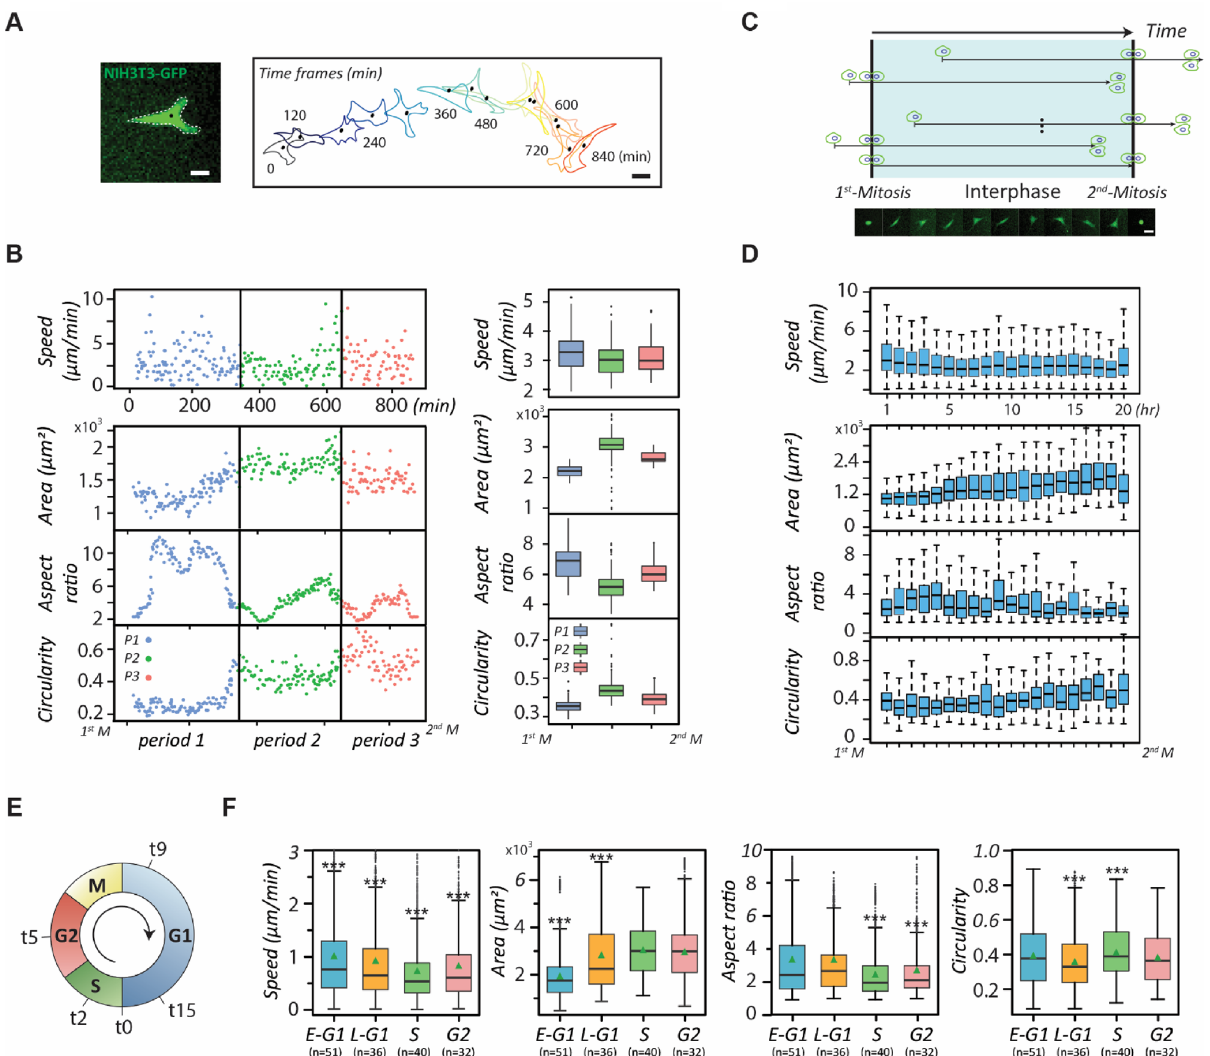
Figure 1. The evolution of migration and morphology of NIH fibroblasts over the cell cycle. ( A ) Green fluorescent protein (GFP)-labelled single NIH3T3 fibroblasts monitored at 3-min time intervals over an entire cell cycle beginning at cell-division. The time-evolved cell outlines and corresponding cell centroids over the entire cell cycle of a fibroblast are shown. Scale bar: 20 µm. ( B ) Scatter plots (left) and Box plots (right) showing the dynamic and morphological evolutions of single NIH 3T3 fibroblasts during the cell cycle progression. The cell phenotypes, including instantaneous speed, area, aspect ratio, and circularity were monitored at 3-min time intervals throughout the cell cycle. The perpendicular lines separate periods exhibiting different cell phenotypes. ( C ) The schematic of the time course alignments of live, single cells tracked over 20 h, related to Fig. 1D. The series of micrographs show the morphological evolution of the GFP-labeled NIH 3T3 fibroblasts over the whole cell cycle. Scale bar: 20 µm. ( D ) The box plots verifying cell phenotype evolutions over the cell cycle using 20 cells. ( E ) The plot representing the time of the optimal profiles of double-thymidine-synchronized cells that propagate to the early G1, the late G1, the S, and the G2 phase, determined as 9, 15, 2, and 5 h, respectively (and denoted as t9, t15, t2, and t5, respectively). ( F ) The box plots showing the dynamic and morphological measurements of synchronized NIH 3T3 fibroblasts (n > 20) in different stages of the cell cycle phases. Data information: *** indicates that the group of data is statistically significant compared to other groups. The statistical results of this figure are listed in Supplementary Table